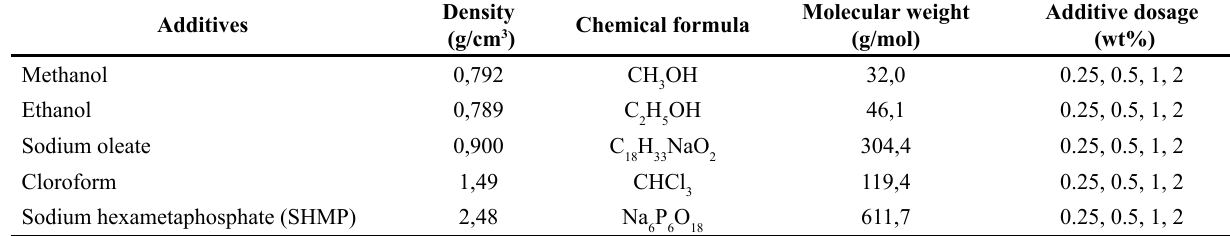
Table 2 . Physical properties and addition amount of grinding aids used